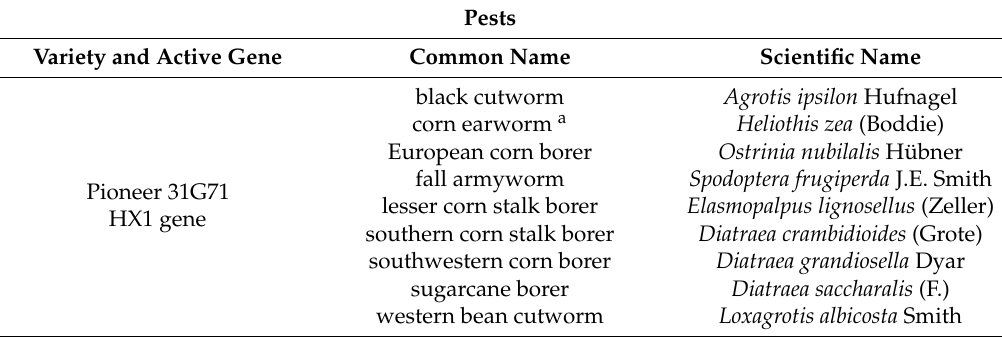
Variety and Active